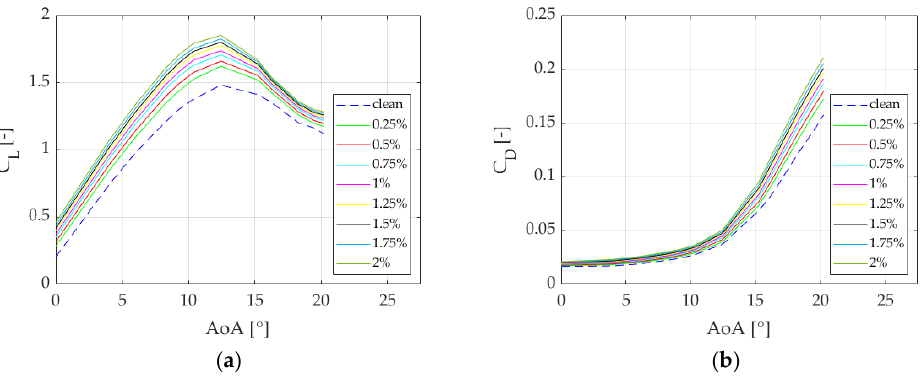
Figure 6. C L ( a ) and C D ( b ) curves of the DU97W300 airfoil with different GF lengths (0% to 2% of